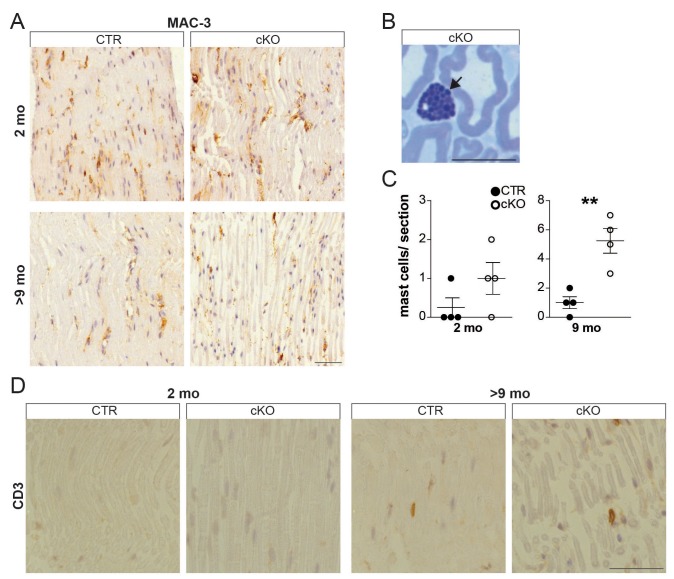
Young Pex5 mutant nerves lack signs of inflammation.(A, D) Chromogenic immunostaining for MAC-3 (A) and CD3 (D) on longitudinal paraffin-embedded sciatic nerve sections of mice aged 2 and 9 months. (B, C) Mast cells (arrow) visualized and quantified using entire semithin (500 nm) methylene-blue-stained cross-sections of mouse sciatic nerves at 2 months of age (n = 4). Statistics: means ± s.e.m. *p<0.05; **p<0.01; ***p<0.001; Student’s T-test.